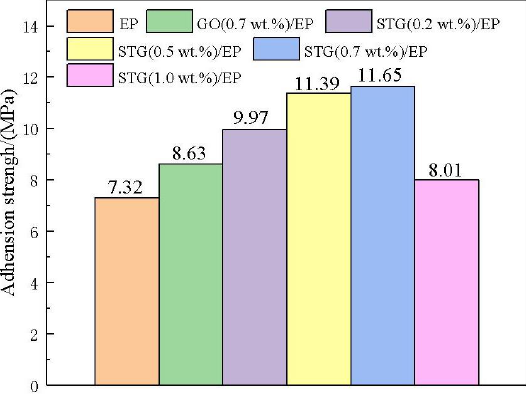
Figure 10. Diagram of coatings adhesion test.